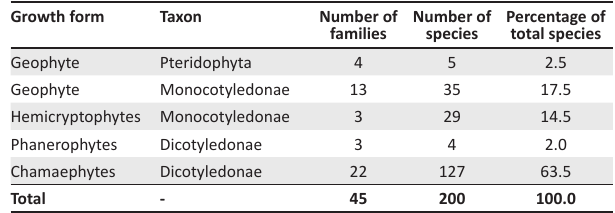
TABLE 3: Representation of growth forms within inselberg